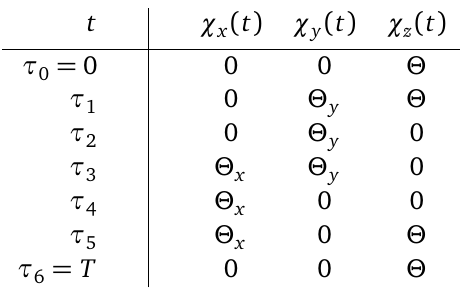
( t ) at the key configurations t = τ i